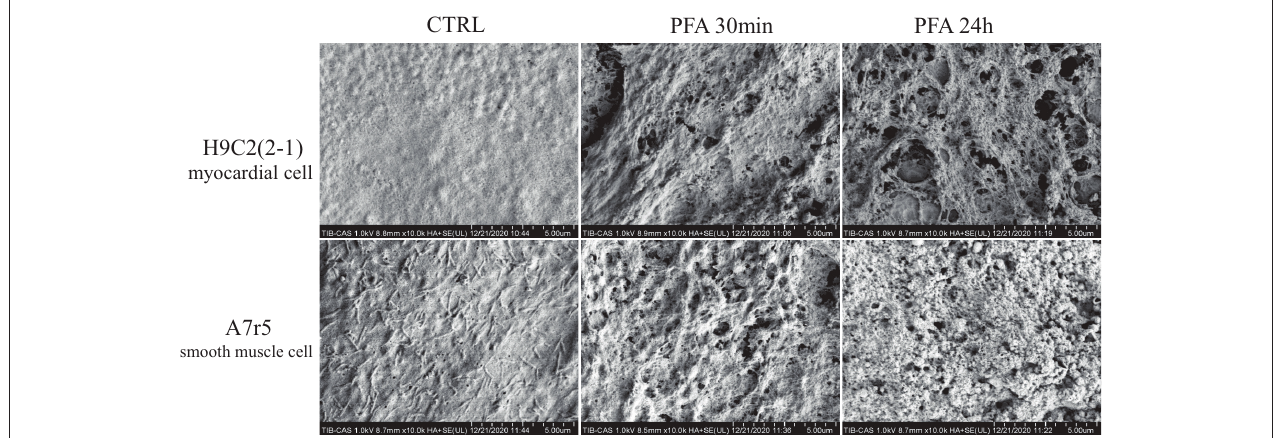
FIGURE 3 | SEM images of H9C2(2-1) and A7r5 cells inoculated in transwell inserts 30min and 24h after PFA by × 10,000 magnification. SEM, scanning electron microscopy; PFA, pulsed-field